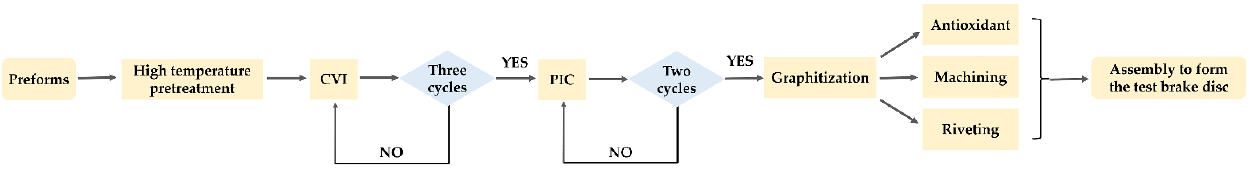
Figure 1. The preparation processes of the test discs.